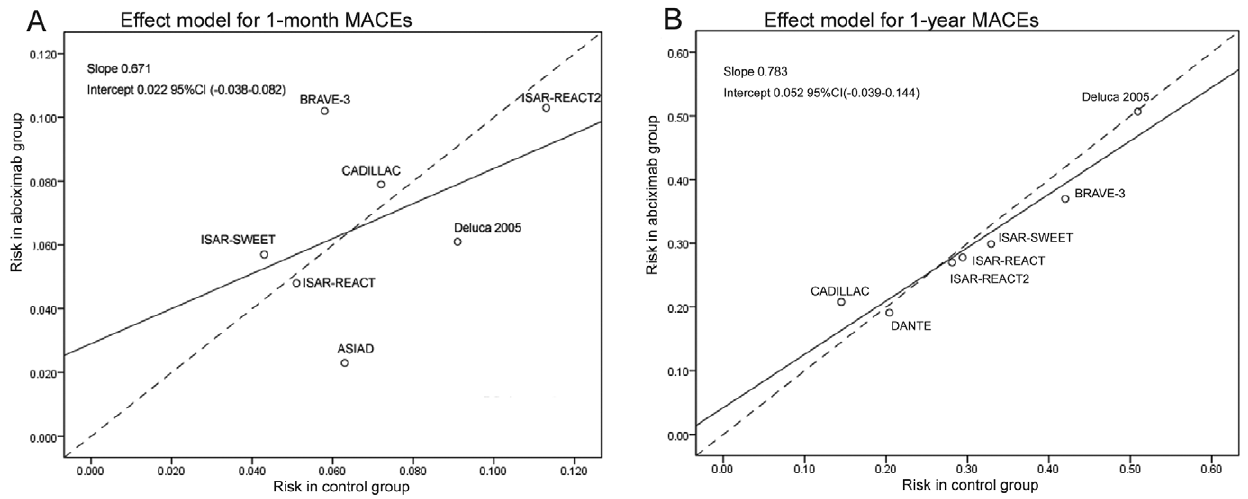
Figure 6. Effect model analysis of abciximab therapy on MACEs. (A) 1-month; (B) 1-year. Weight regression line (solid line) was shown between MACEs in diabetic patients who used abiximab (y axis) and non-users (x axis). The bisector (dashed line) means the lack of difference between groups.